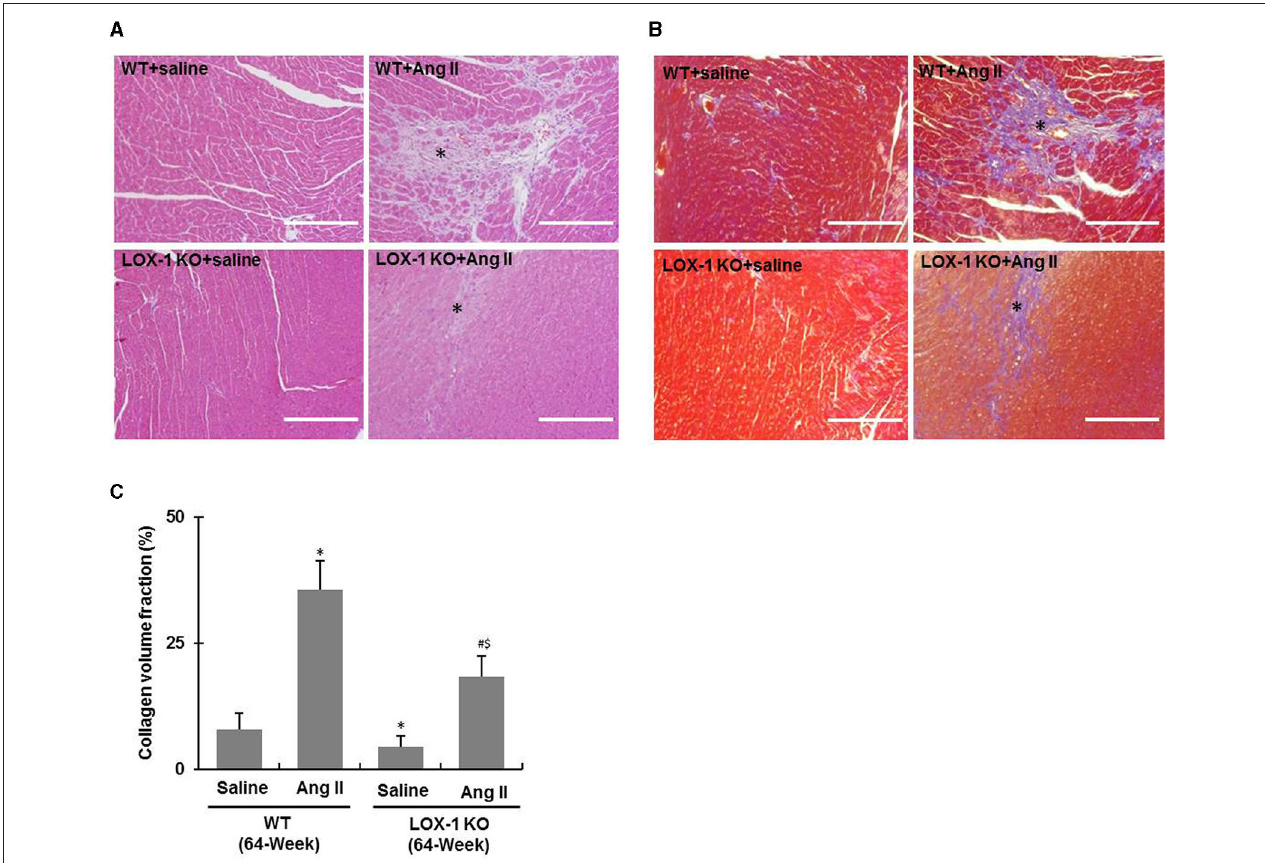
FIGURE 5 | Cardiac fibrosis of each group of mice following infusion with Ang II or saline for 4 weeks. (A) Representative HE staining images; (B) Representative Masson’s trichrome staining images. Asterisks indicating fibrotic scars. (C) Quantification of collagen volume fraction in Masson’s trichrome staining images. n = 6 /group. * P < 0.05, vs. WT + saline group; # P < 0.05, vs. LOX-1 KO + saline group; $ P < 0.05, vs. WT + Ang II group. Scale bars represent 200 µ